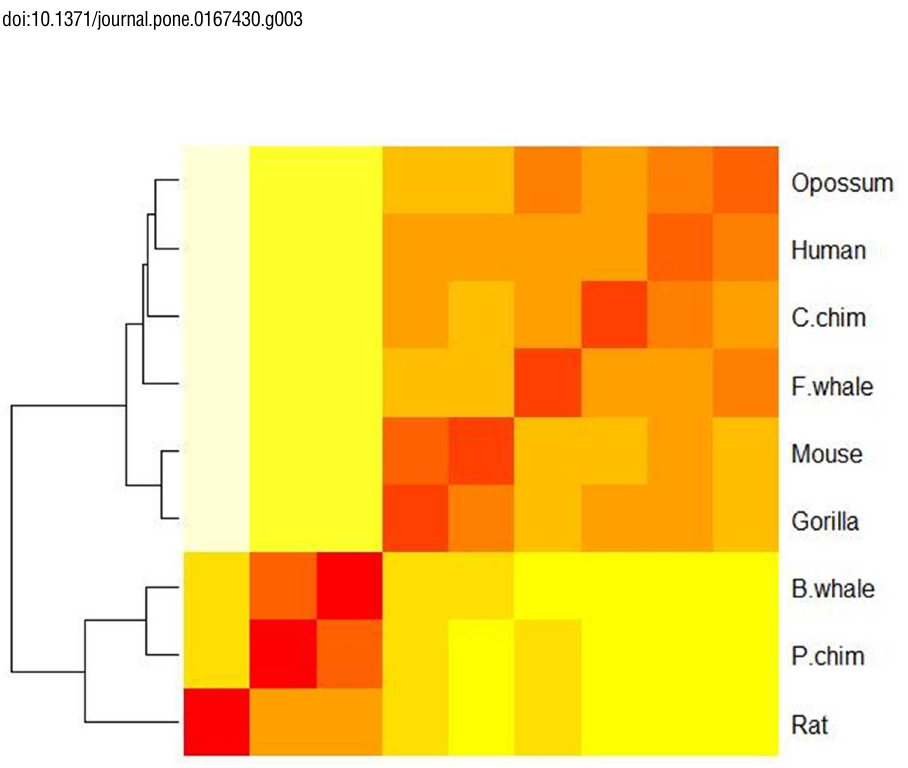
Fig 4. A heat map showing the similarity of nine species in the ND5 dataset based on the 20-D amino acid position ratio